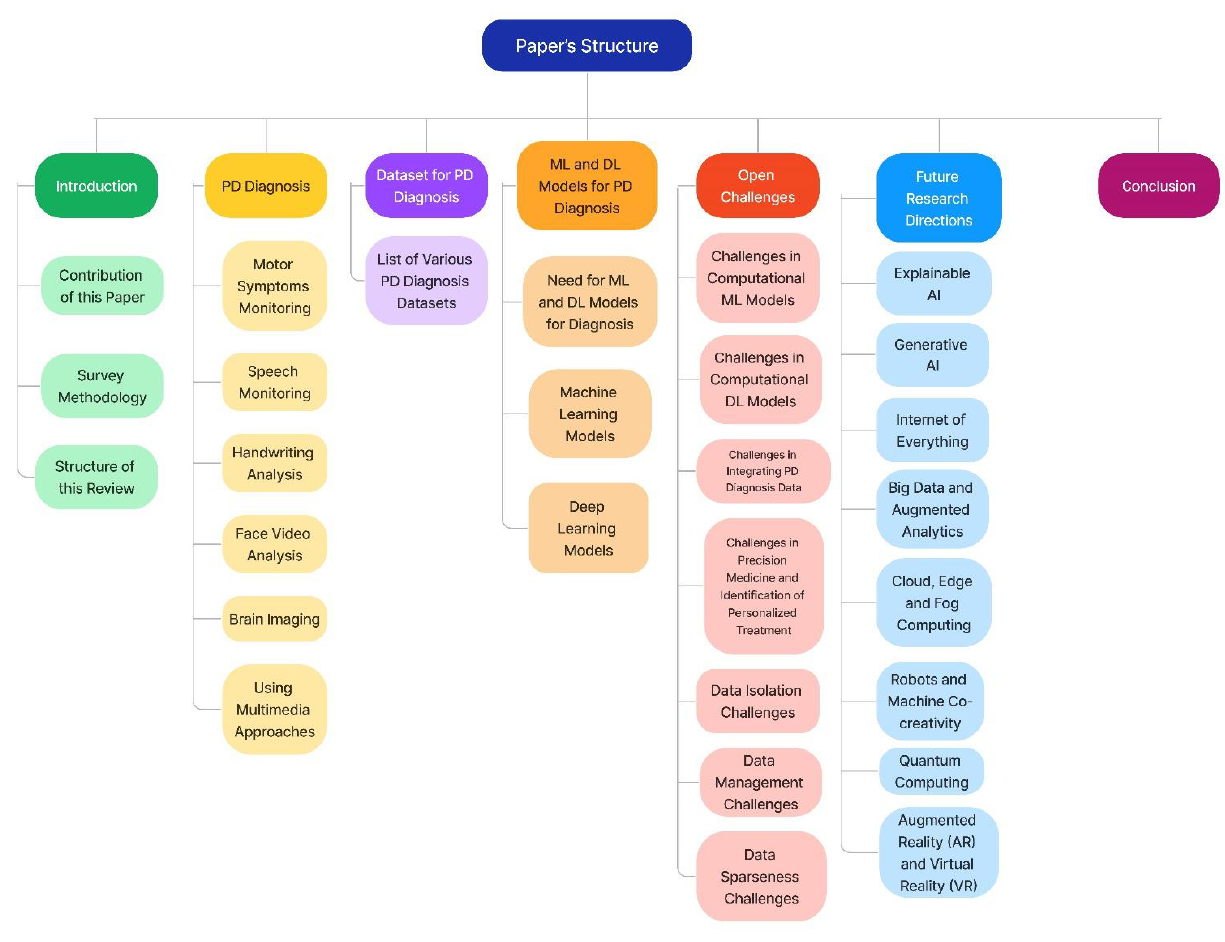
Figure 3. Structure of this review